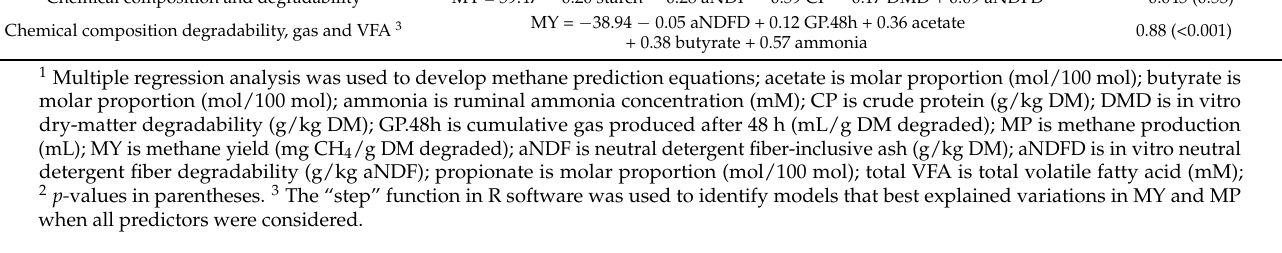
Figure 4. A correlogram showing the correlation between chemical composition, degradation, and fermentation end-products over location and whole-plant cereal varieties grown and harvested in central Alberta. Positive and negative correlation coefficients are displayed in blue and red scale, respectively (0.5 to 1 or − 1 to − 0.5; p < 0.05). All chemical composition in g/kg DM; ammonia is m M ; CP is crude protein (g/kg DM); DMD is in vitro dry-matter degradability (g/kg DM); GP is cumulative gas produced after 48 h (mL/g DM degraded); MP is methane production (mL); MY is methane yield (mg CH 4 /g DM degraded); aNDF is neutral detergent fiber-inclusive ash (g/kg DM); aNDFD is in vitro neutral detergent fiber degradability (g/kg aNDF); Total_VFA is total volatile fatty acid (mM); VFA profile (acetate, propionate and butyrate) in mol/100 mol. Multiple regression analysis showed that chemical composition alone explained 45% gradabilities explained 66% of the variation ( p ≤ 0.02; Table 5). However, the best-fit pre- diction for MP was DMD combined with GP at 48 h, explaining 92% of the variation ( p < 0.001). In contrast, chemical composition (starch, aNDF, and CP concentrations) of the WPC alone or together with nutrient degradabilities (DMD and aNDFD) failed to explain the variation in MY (R 2 ≤ 0.04; p ≥ 0.35). The variation in MY was mostly explained by the combined effects of aNDFD concentration, GP after 48 h, total VFA production, propor- tions of acetate and butyrate, and ammonia concentration (R 2 = 0.88; p < 0.001). Table 5. Prediction equations for methane based on chemical composition, degradation, and fermentation end-products over two locations and two varieties of each cereal crop (barley, oat, triticale, and wheat) grown and harvested in central Alberta.